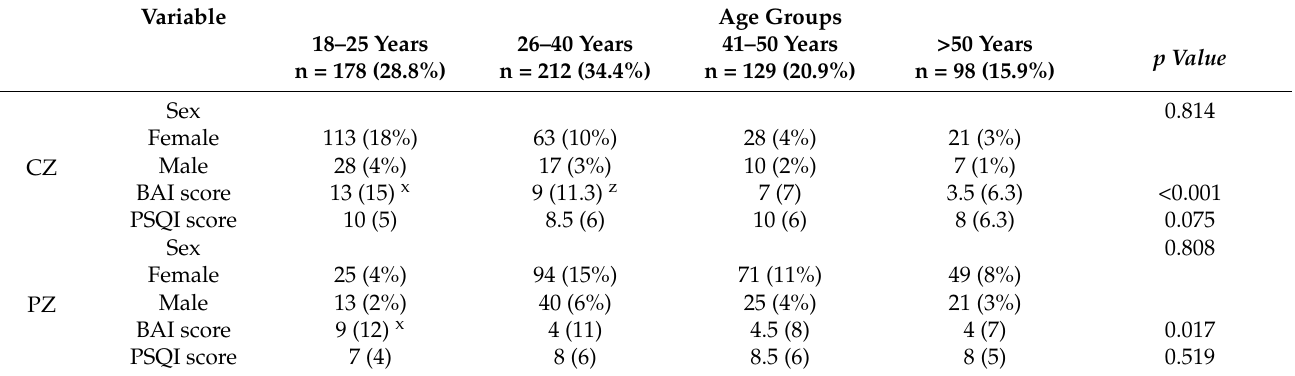
Table 1. Sociodemographic characteristics according to area, age group, and psychometric